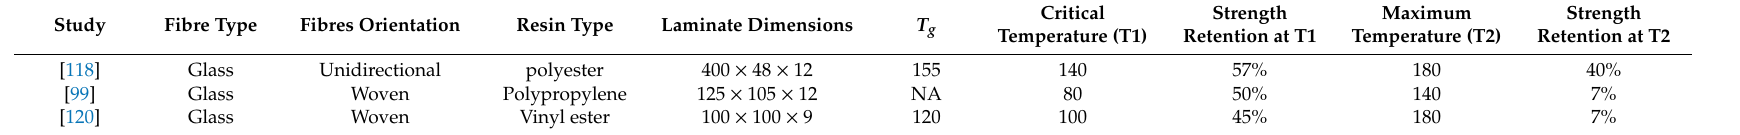
Table 5. FRP laminates / sheets compressive properties after exposure to elevated